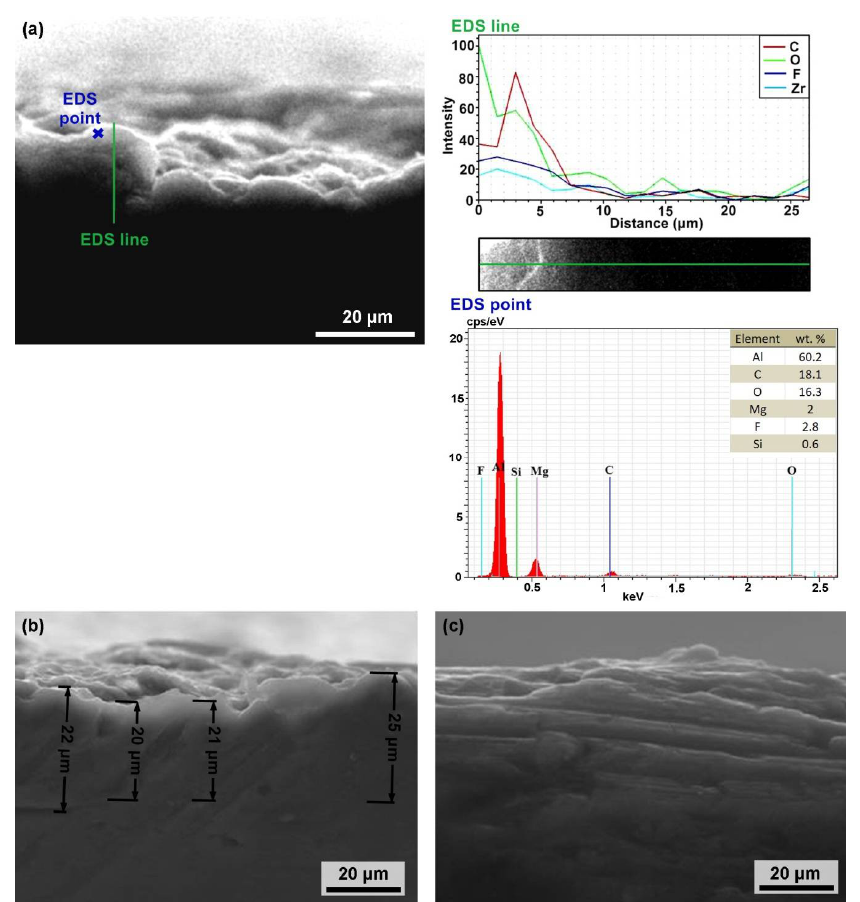
Figure 6. ( a ) The morphology of the resulting micro-coat in a cross section (SEM) including the EDX measurement in a straight line and at a point, ( b ) a cross section of a micro-coated sample with the measurement of its thickness and ( c ) the morphology of the